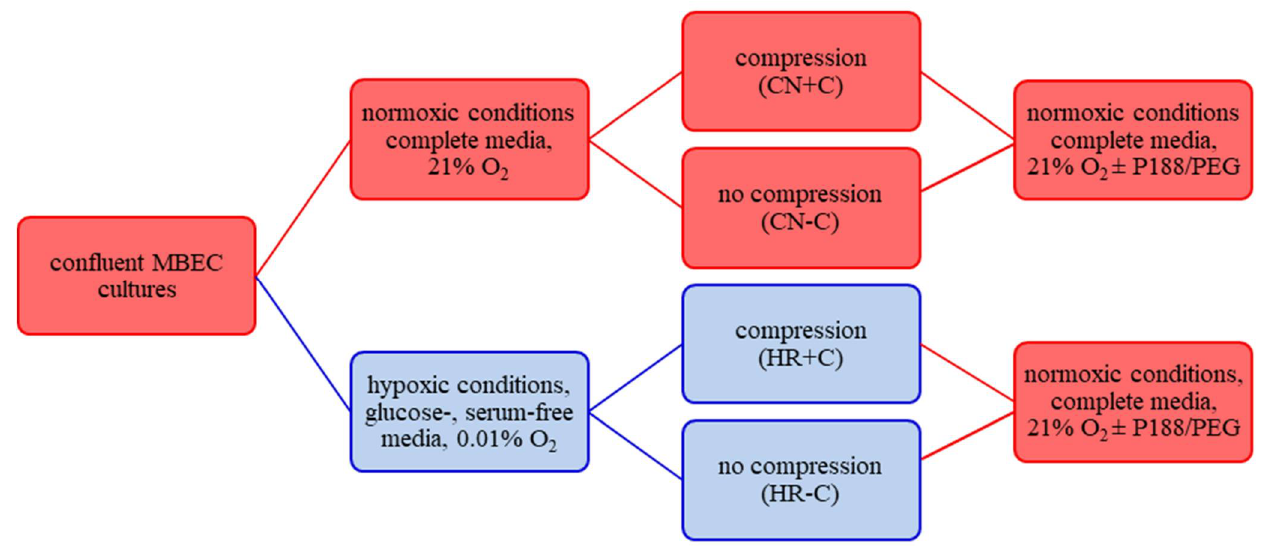
Figure 1. Schematic representation of the experimental setup. CN-C was used as control, while CN+C simulated contusion, HR-C represented stroke and HR+C mimicked traumatic brain injury. Abbreviations: cm, centimeter; MBEC, mouse primary brain microvascular endothelial cells; O 2 , Oxygen; P188, Poloxamer 188; PEG, polyethylene glycol; Colors: red, normoxic conditions; blue, hypoxic conditions.